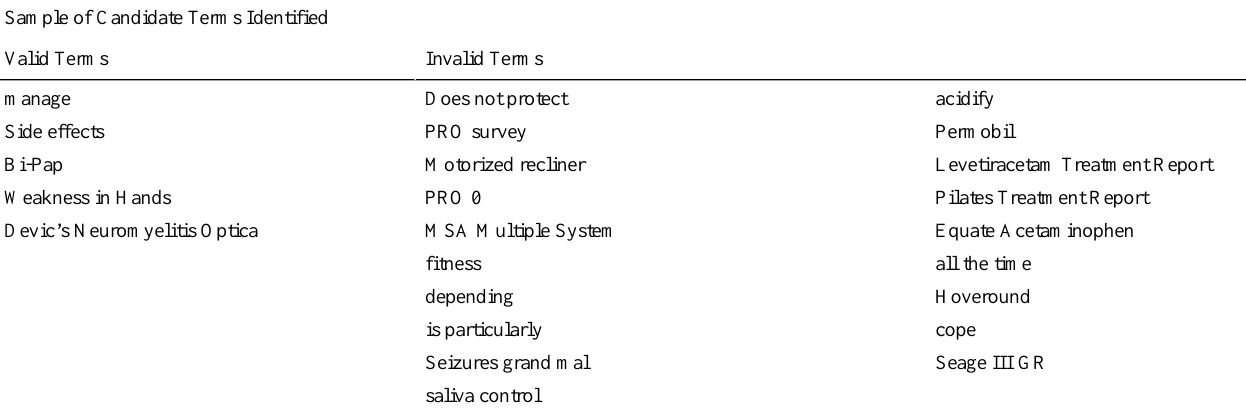
Table 2. Sample list of valid and invalid candidate terms identified (displayed in no particular order and in the format in which they were found) Sample of Candidate Terms